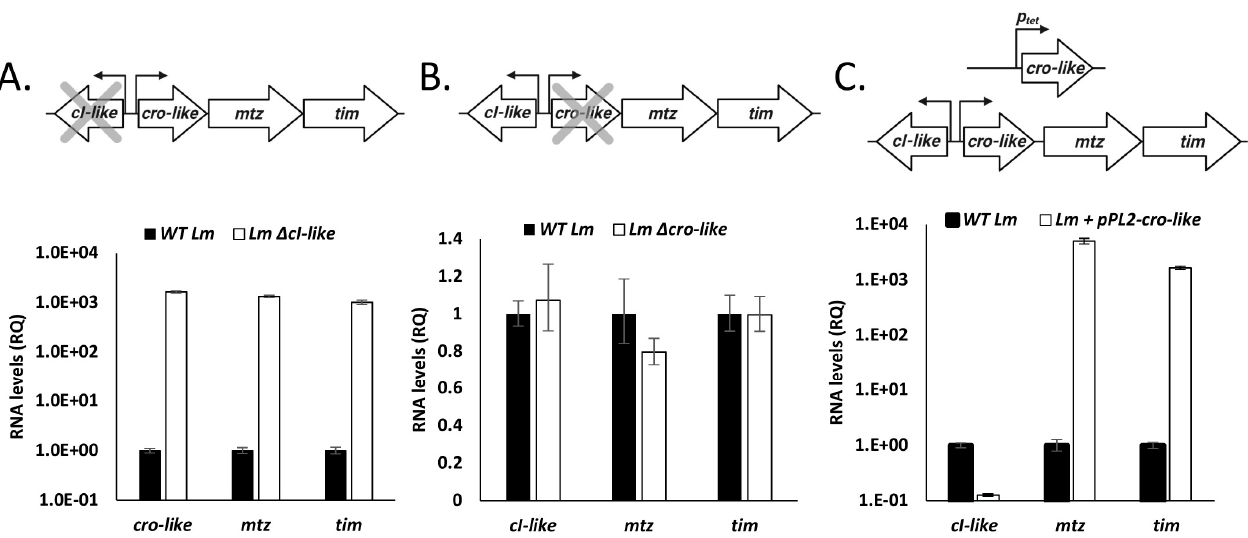
Figure 2. The cI-cro -like locus possesses the transcriptional dynamics of a phage regulatory switch. RT-qPCR transcriptional analysis of the cI-cro -like locus transcripts obtained from WT Lm grown to mid-log phase in BHI at 37 ◦ C, and from bacteria deleted for the cI -like gene ( A ), deleted for the cro -like gene ( B ), or ectopically expressing the cro -like gene under regulation of p tetR promoter ( C ). Data are presented as relative quantity (RQ) compared to the mRNA levels in WT bacteria, normalized to the levels of the rpoD gene. The data represent three independent experiments. Error bars indicate the 95% confidence interval.